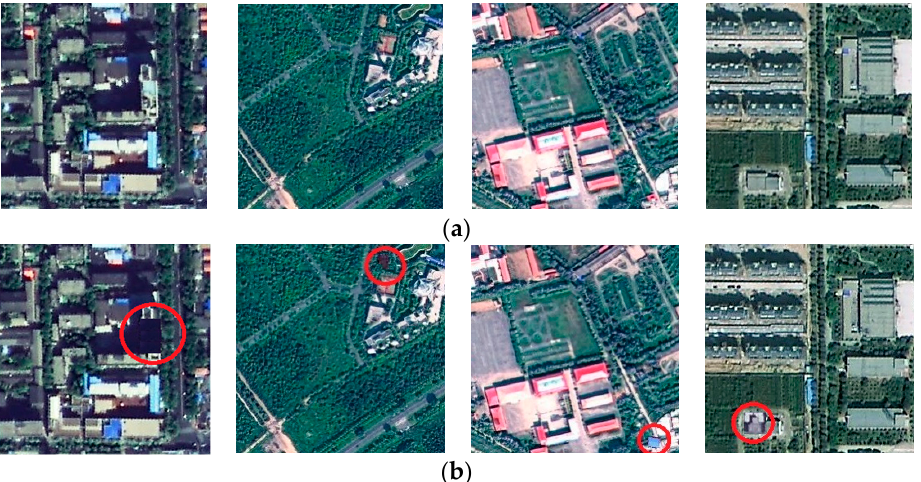
Figure 11. Tampering examples of changing object: ( a ) Original HRRS images, ( b ) corresponding tampered images.